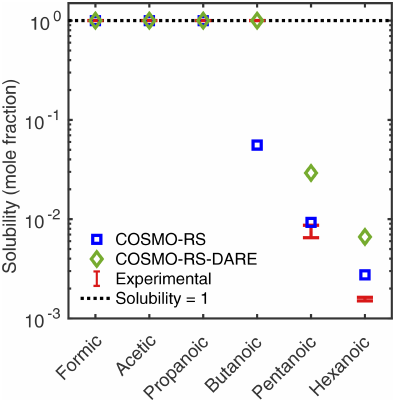
Figure 7. COSMO therm -estimated aqueous solubility of mono- carboxylic acids calculated using COSMO-RS and COSMO-RS- DARE, at 298.15K. Experimental solubilities by Saxena and Hilde- mann (1996) ( n = 1–6) and Romero and Suárez (2009) ( n = 5–6).